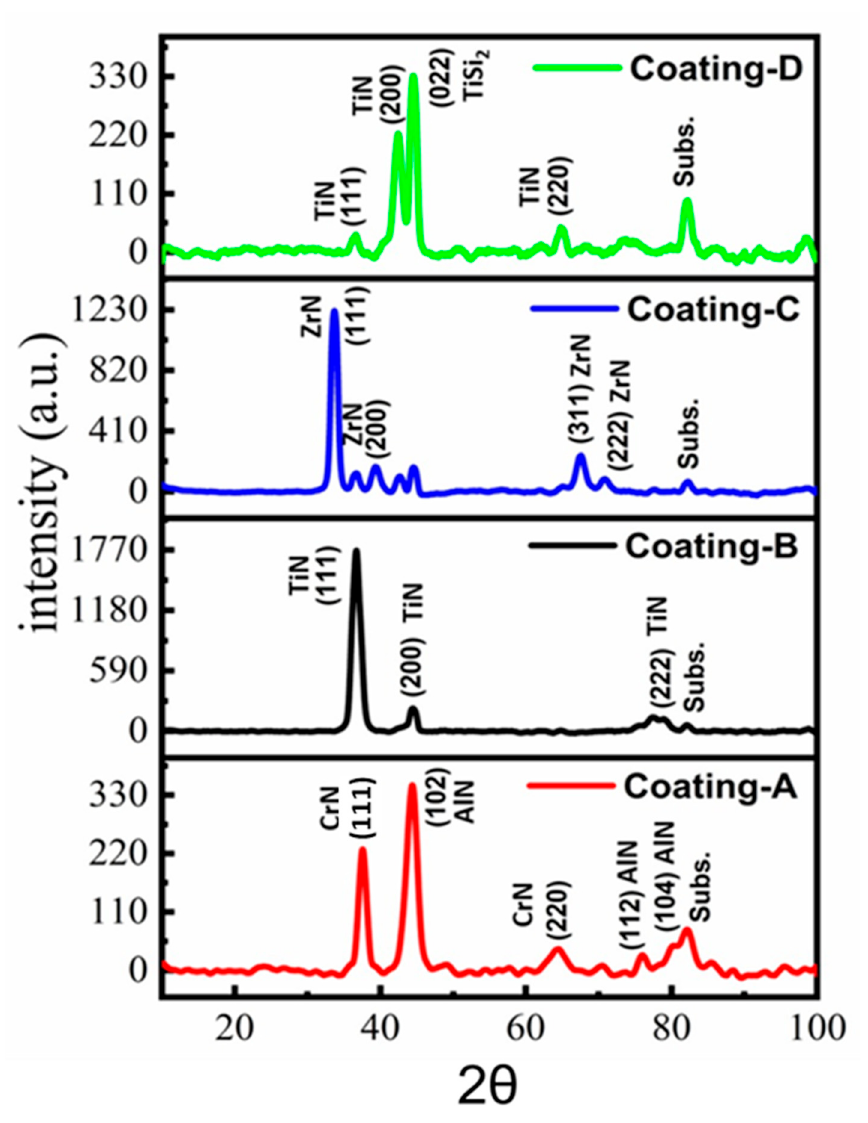
Figure 4. Phase analysis of the coatings, XRD.